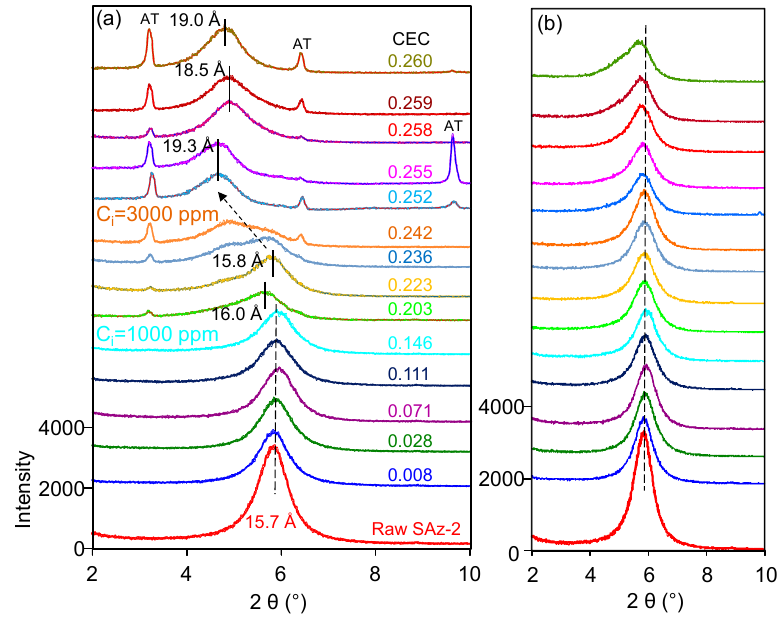
Figure 7. XRD patterns of raw SAz-2 and SAz-2 with different amounts of AT intercalation at pH10 when XRD thin sections were made with ( a ) and without ( b ) AT recrystallization, respectively.